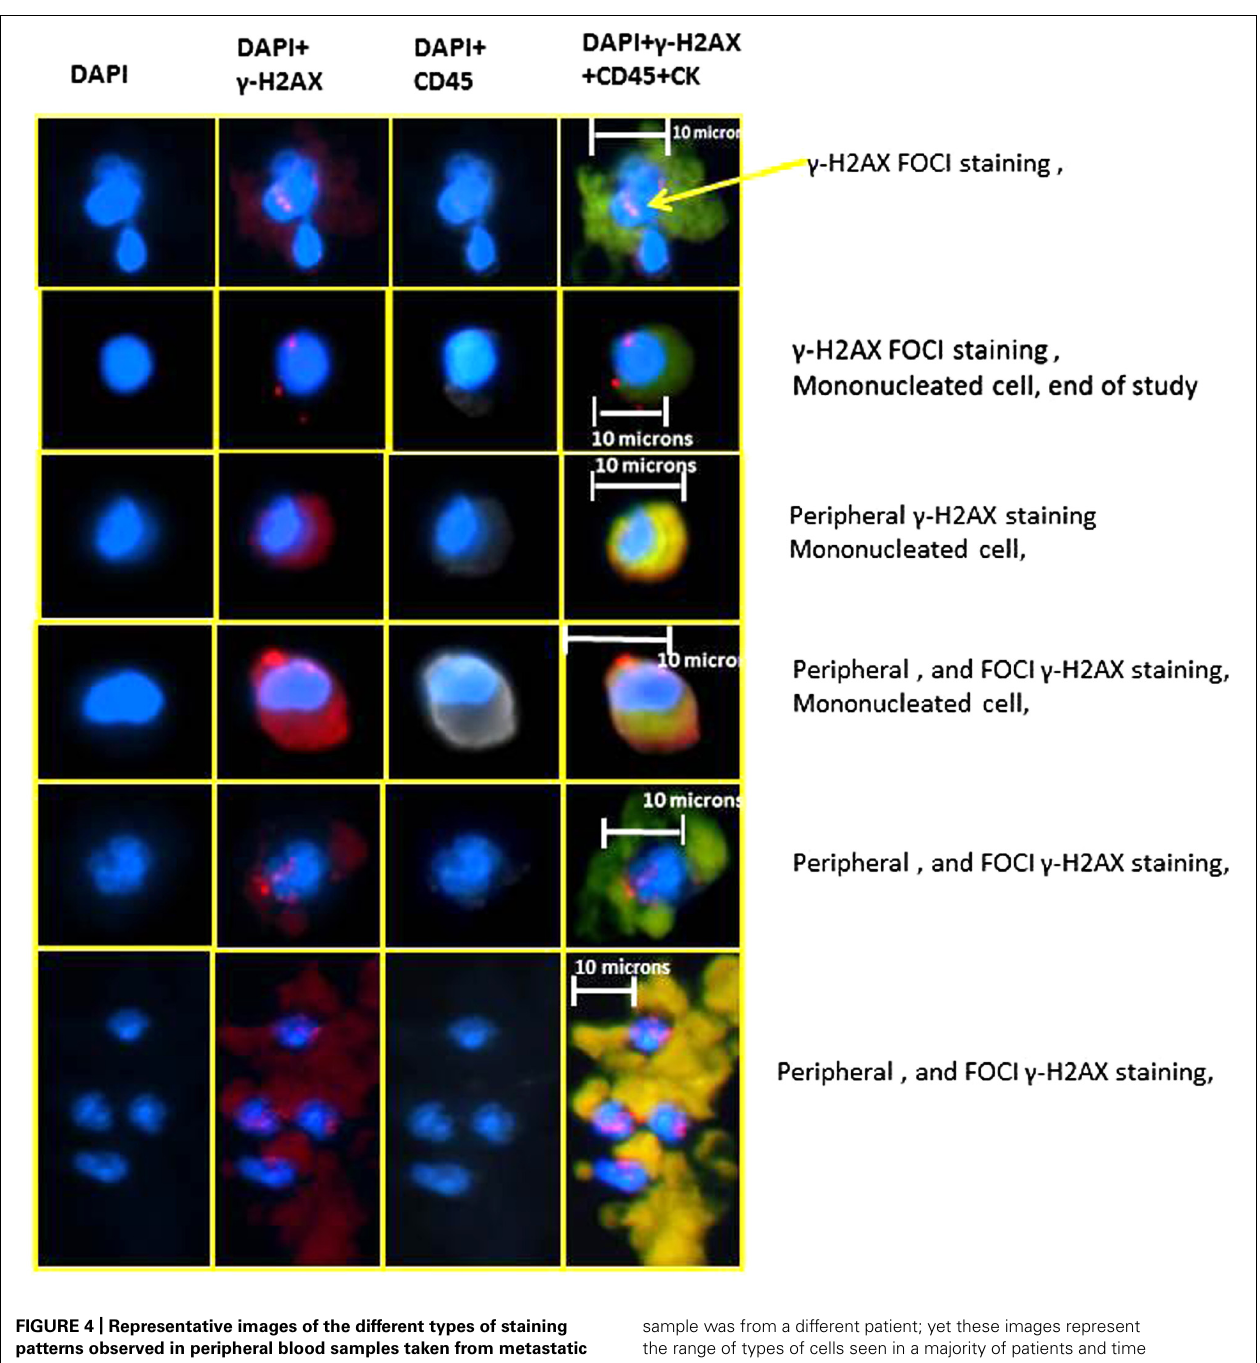
FIGURE 4 | Representative images of the different types of staining patterns observed in peripheral blood samples taken from metastatic breast cancer patients undergoing a phase I, two drug trail. Each